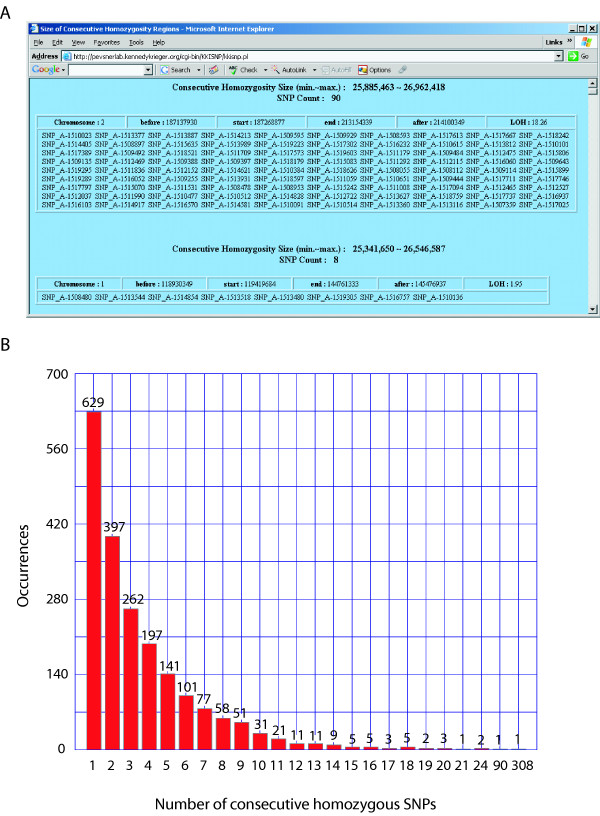
SNPscan plots and tables for data analysis. The SNPscan website offers a set of tools for the analysis genotype calls, including a description of SNPs in regions of consecutive homozygous calls (i.e. LOH) in table form (A) or with a plot (B). Both panels are screen shots; the labels in B have been redrawn for clarity.